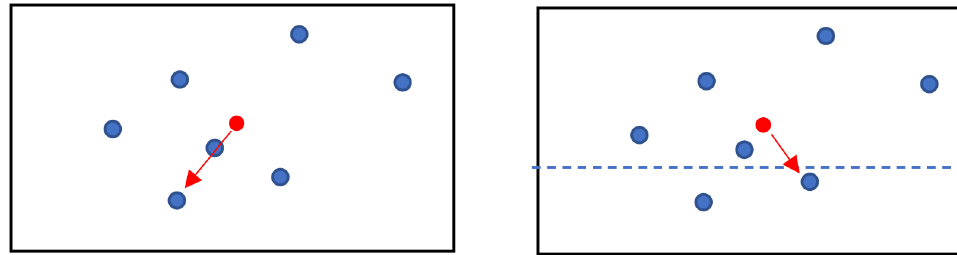
Figure 7. Representation of the moving-target TSP method ( left ) and the hybrid method with the added nearest neighbors variant ( right